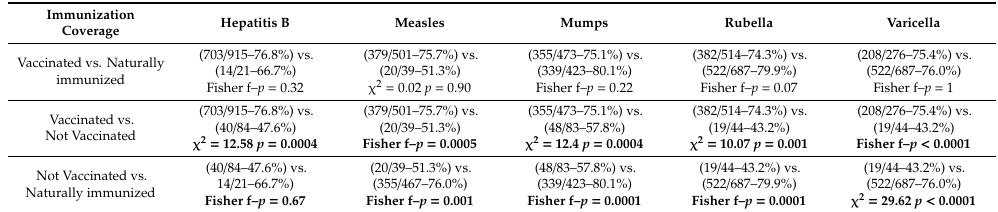
Table 4. Comparison among PHPs recommending vaccinations according to immunization coverage (statistically significant di ff erences in